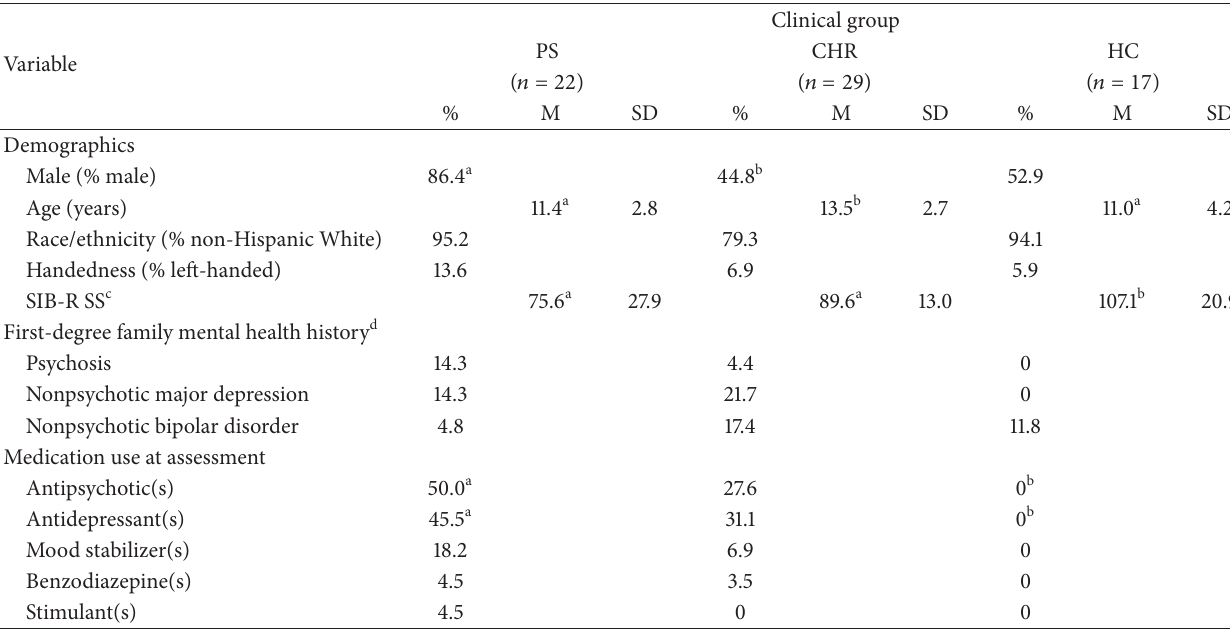
Table 1: Demographic and clinical characteristics of clinical